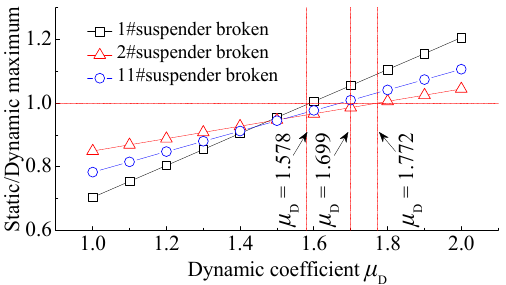
Figure 23. Comparison between the longitudinal beam stress based on the dynamic and static analyses.